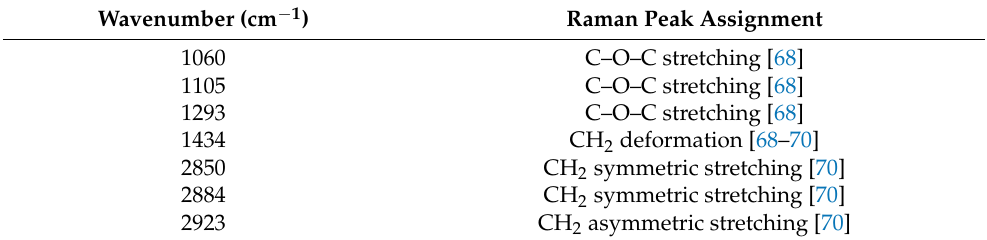
Table 1. Major Raman peaks identified and their related assignments.